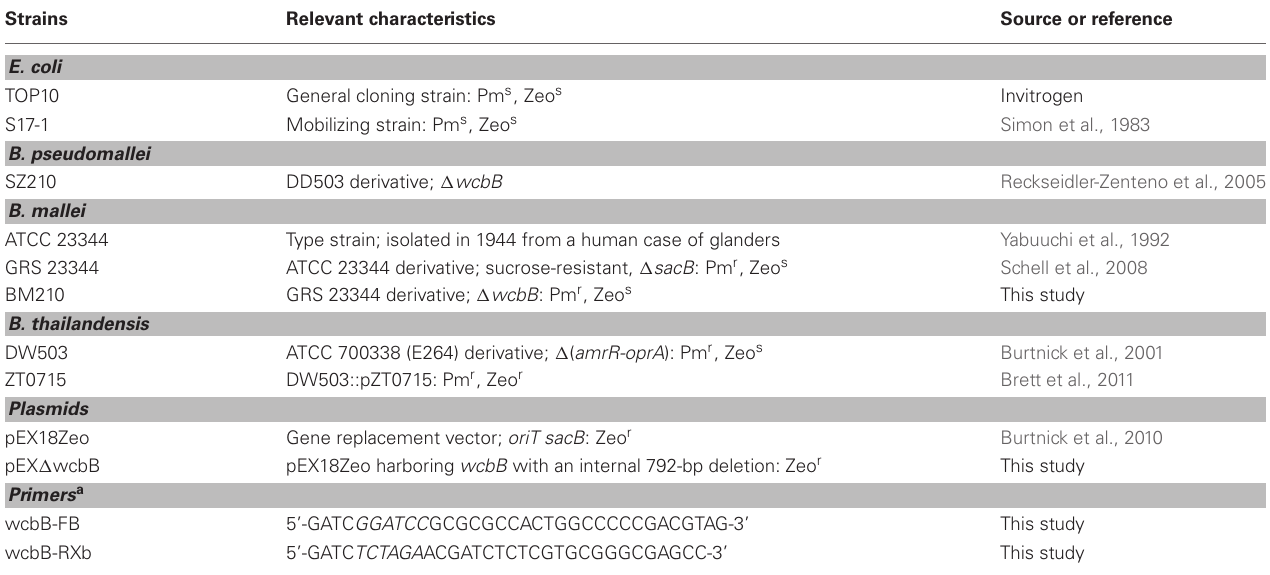
Table 1 | Strains, plasmids, and